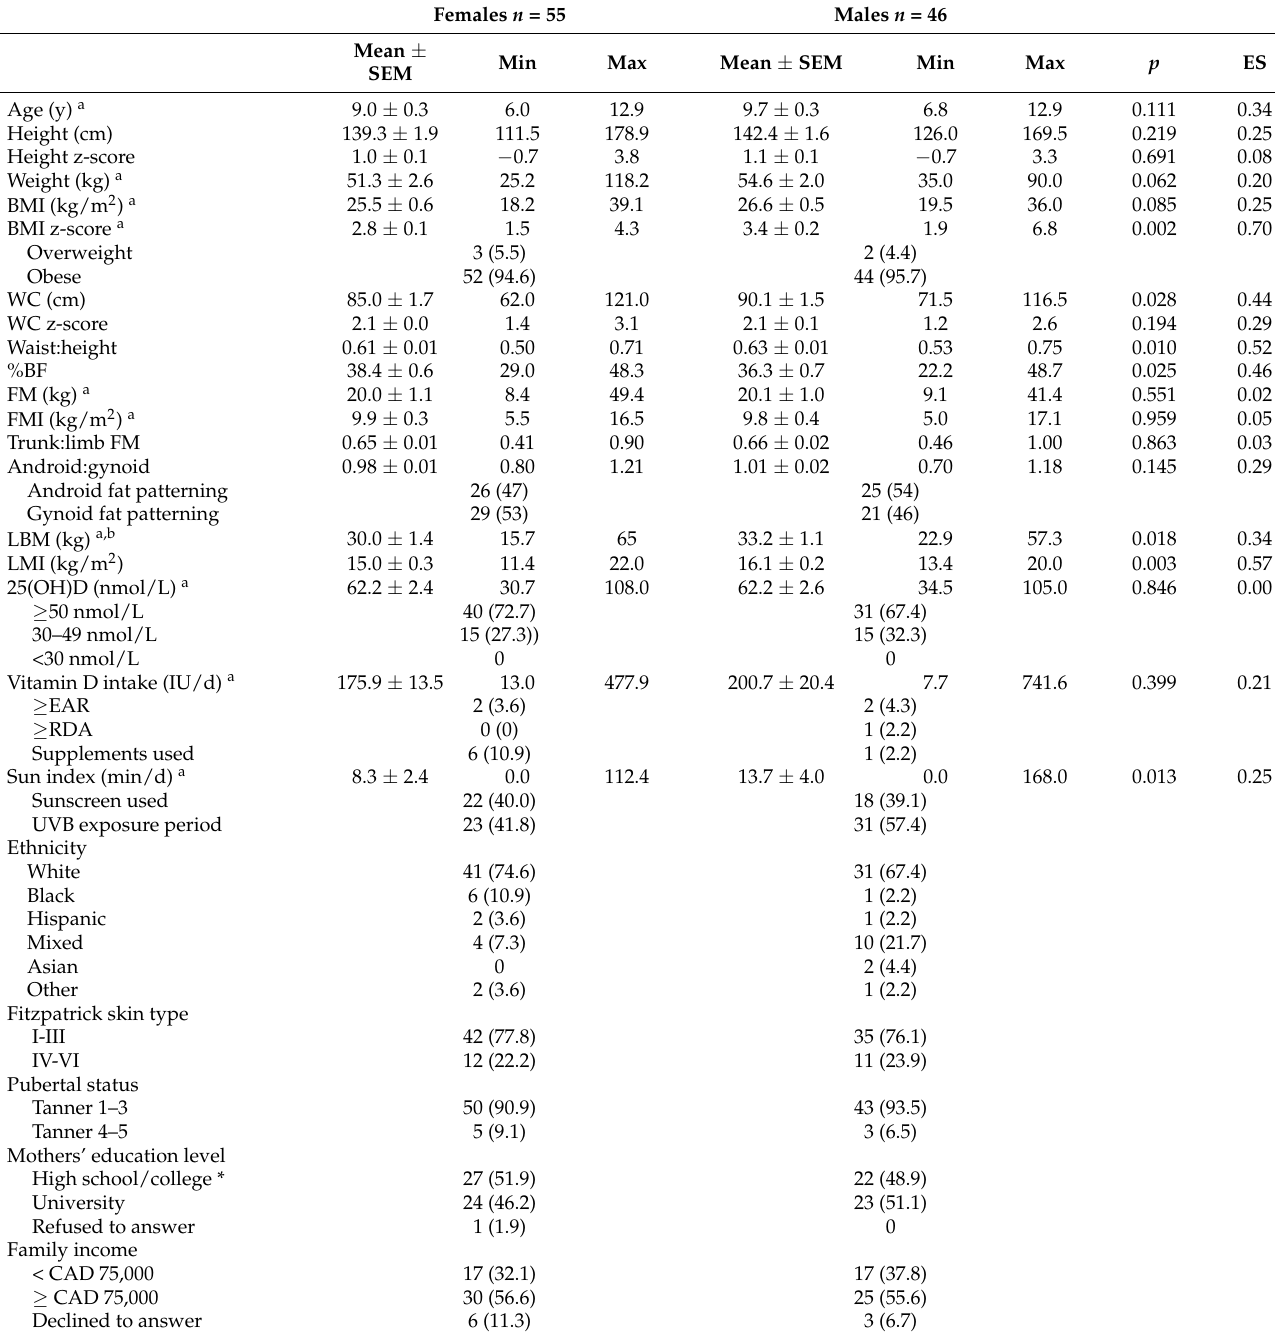
Table 1. Baseline characteristics of children included in this